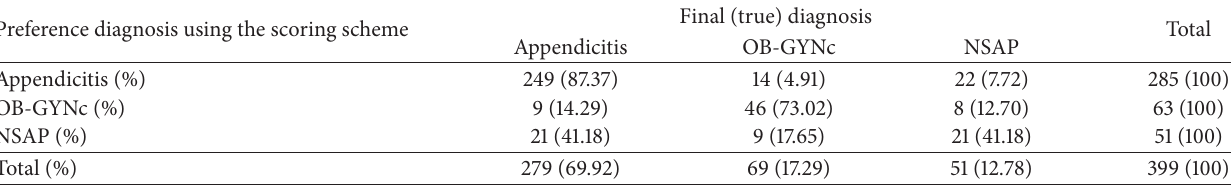
Table 4: Performance of the diagnostic preferences using the derived scoring scheme for appendicitis, common obstetrics and gynecological conditions (OB-GYNc), and nonspecific abdominal pain (NSAP).